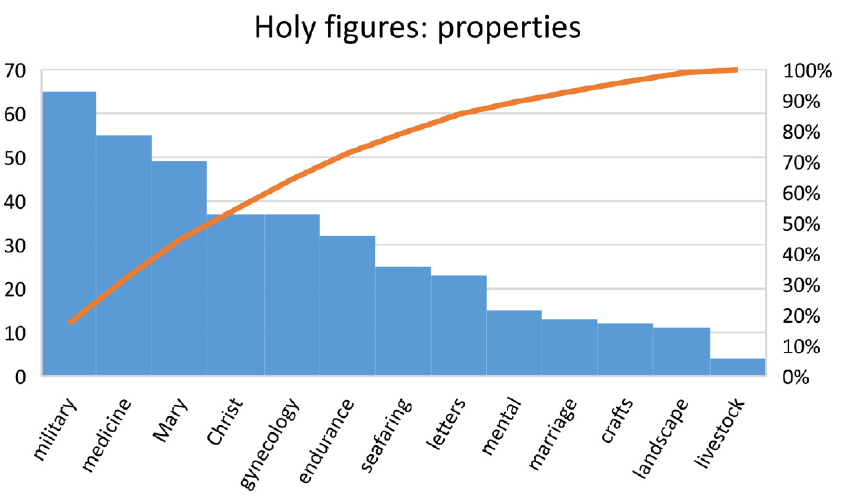
Figure 13. A graph showing the number of churches dedicated to saintly figures possessing certain qualities and powers (data and graph by the author).